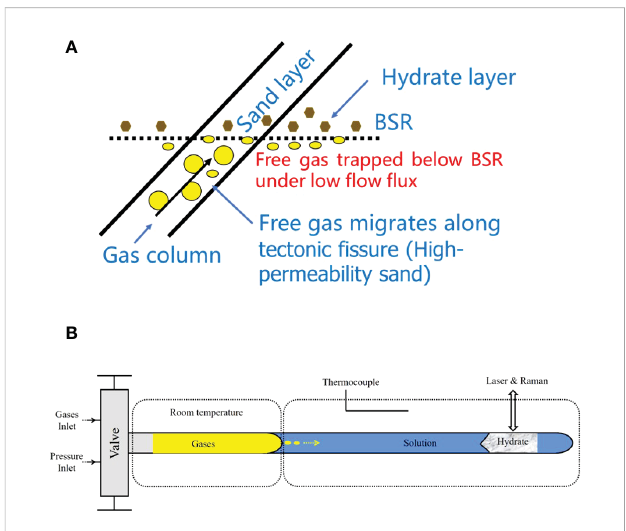
FIGURE 2 The dissolution – migration – hydration process near the bottom- simulating re fl ector (BSR). (A) In a submarine environment, the growth of the hydrate was supplied by guest molecules (i.e., methane and ethane) through diffusion in the aqueous phase from the vapor – aqueous solution interface near the base of the gas hydrate stability zone (BGHSZ). (B) Hydrates were grown from aqueous fl uids supplied by the gases dissolved from the capillary-trapped free gas in a capillary high-pressure optical cell. Yellow arrows indicate the direction of gas migration. The shadow corner line is the boundary between hydrate and water solution, indicating growth